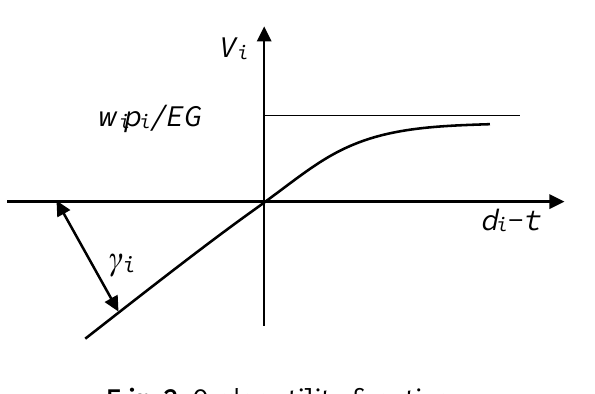
Fig. 2. Order utility